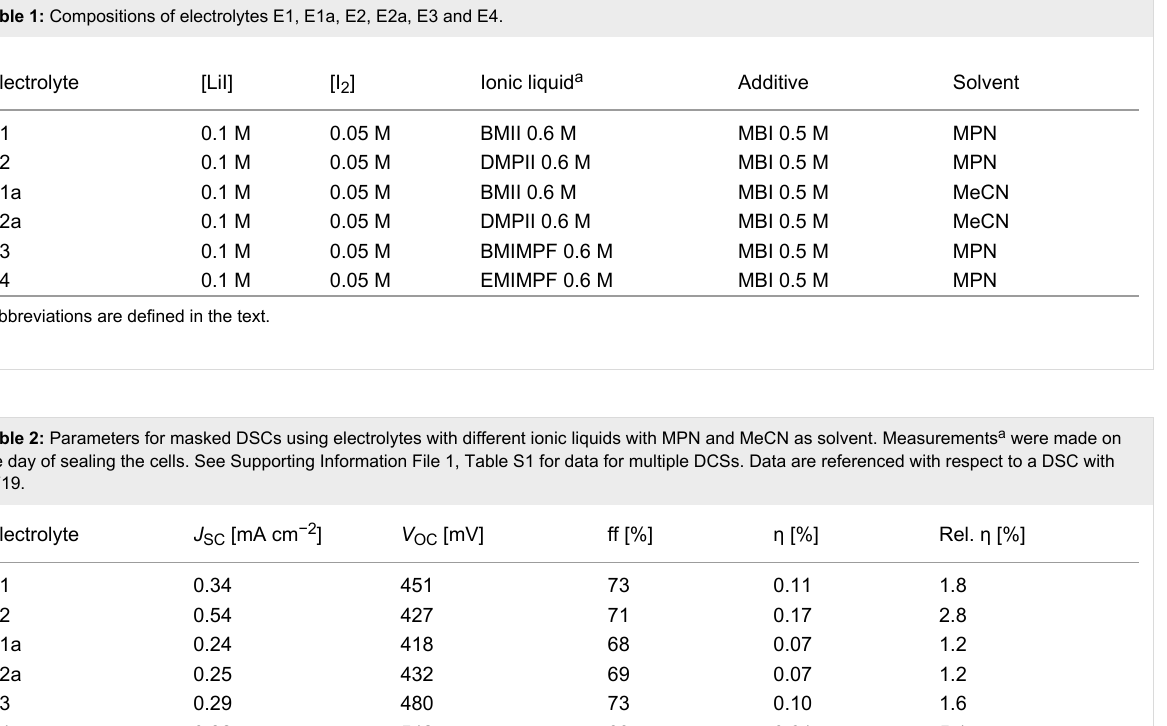
Table 2 are referenced with respect to a DSC sensitized with N719 (Scheme 1) and in the right-hand column of Table 2, rela- tive efficiencies are given with η (N719) set to 100%. Data for multiple cells confirm the reproducibility of the DSC perfor- mances (Table S1, Supporting Information File